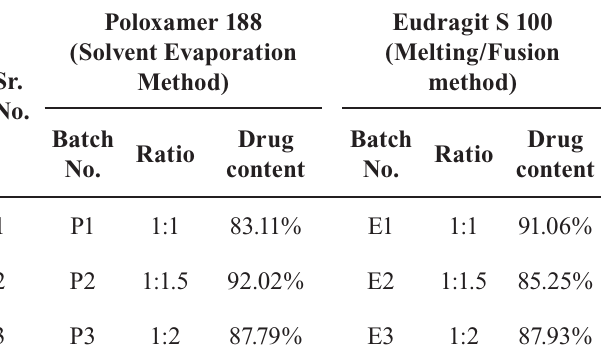
TABLE II - Gibbs free energy values and apparent stability constants (Ka) of Ketoprofen - Poloxamer 188 and Eudragit S 100 interactions